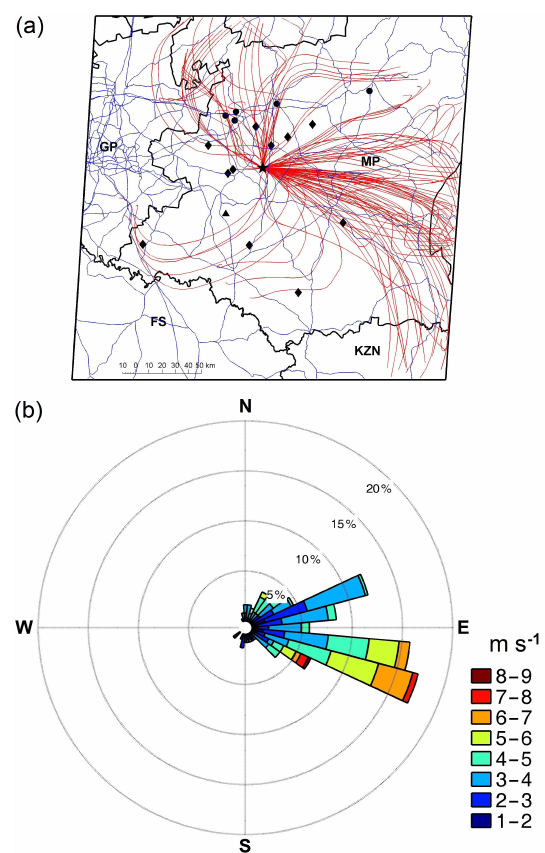
Figure 10. (a) All 24h back trajectories associated with peaks char- acterised by coincidental increases in eBC and NO 2 from Decem- ber to February. The Elandsfontein site is indicated by the black star. The black dots indicate pyrometallurgical smelters and char plants, the black diamonds indicate coal-fired power plants and the black triangle a large petrochemical operation. Roads are indicated with blue lines. (b) Wind rose showing the prevailing wind direction during periods when eBC plumes that coincided with NO 2 plumes were observed.